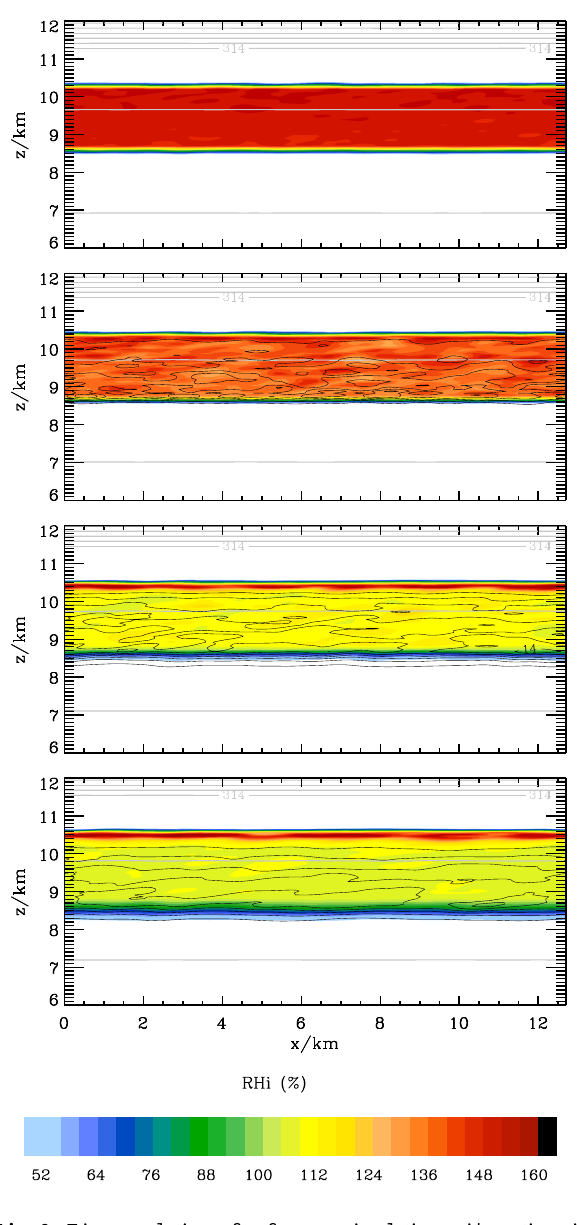
Fig. 9. Time evolution of reference simulation with a time incre- ment of ∆ t = 30 min, starting at t = 60 min (shown are states for t = 60 / 90 / 120 / 150 min, respectively). Black isolines indicate ice water content ( IWC = q c · ρ air , increment ∆IWC = 2mgm − 3 ), grey lines indicate isentropes (increment ∆ θ =4 K).